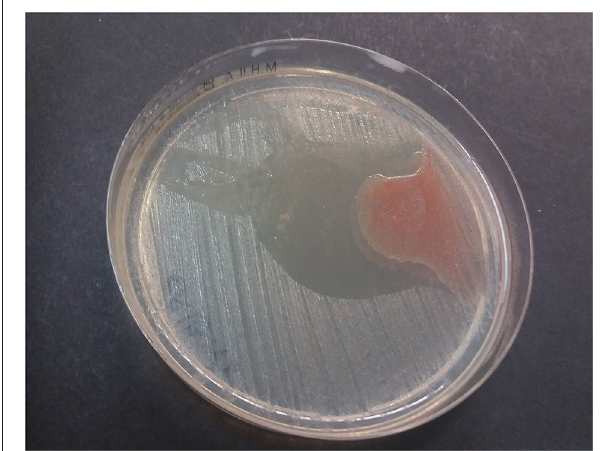
TABLE 3 | Inhibition zones recorded by each hemo-component for multidrug-resistant K. pneumoniae ssp. pneumoniae after 4h of incubation using the Kirby–Bauer